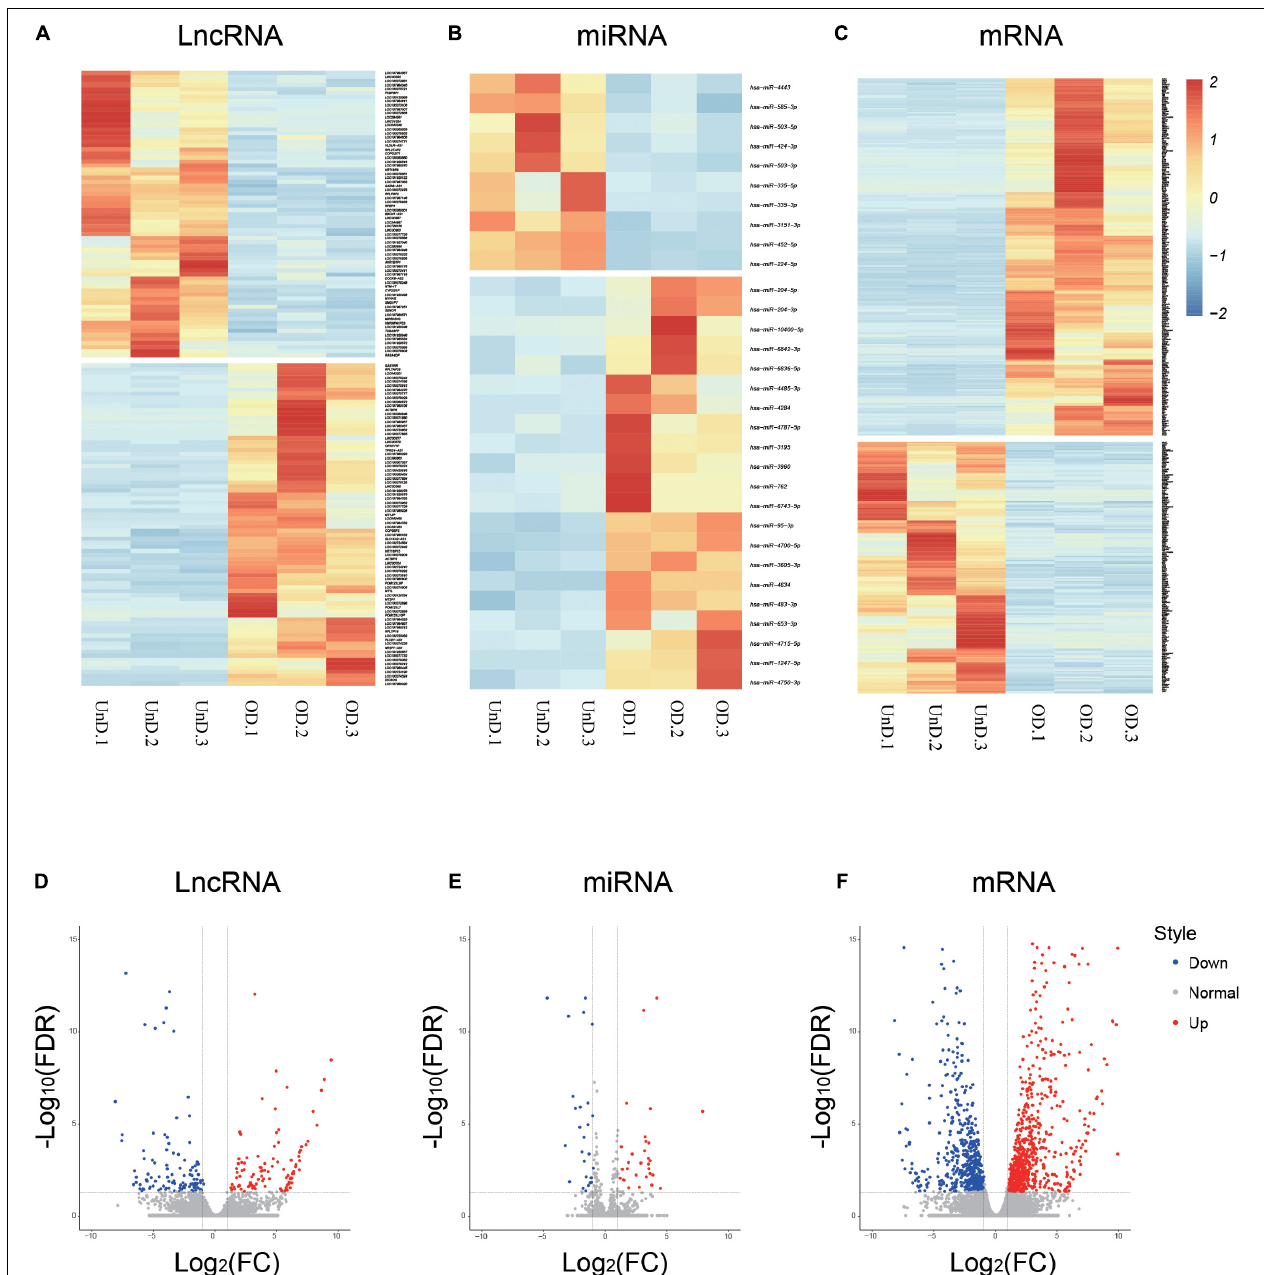
FIGURE 1 | Differential expression profiles of long non-coding RNAs (lncRNAs), microRNA (miRNAs), and mRNAs during osteogenic differentiation. Heat maps (A–C) and volcano plots (D–F) showing differential ncRNA and mRNA expression levels between osteogenic-differentiated bone marrow mesenchymal stem cells (BMSCs) and undifferentiated